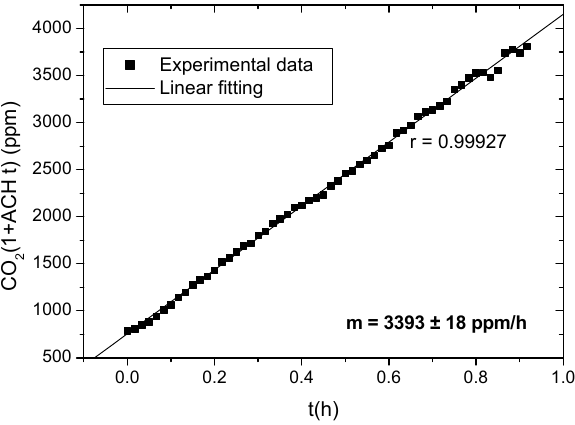
Figure 1. Temporal variations of CO 2 concentrations multiplied by (1 + ACH t) factor for meeting room in measurements in measurement 2.